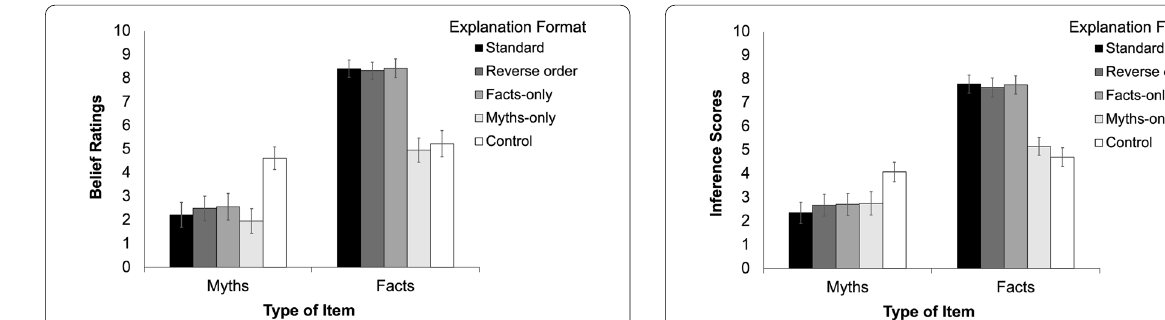
file 1: Table S2 for Holm–Bonferroni corrected compari- sons of fact ratings, which showed that all formats dif- fered from control (except, as expected, the myth-only condition), and the standard format did not differ from the other formats.